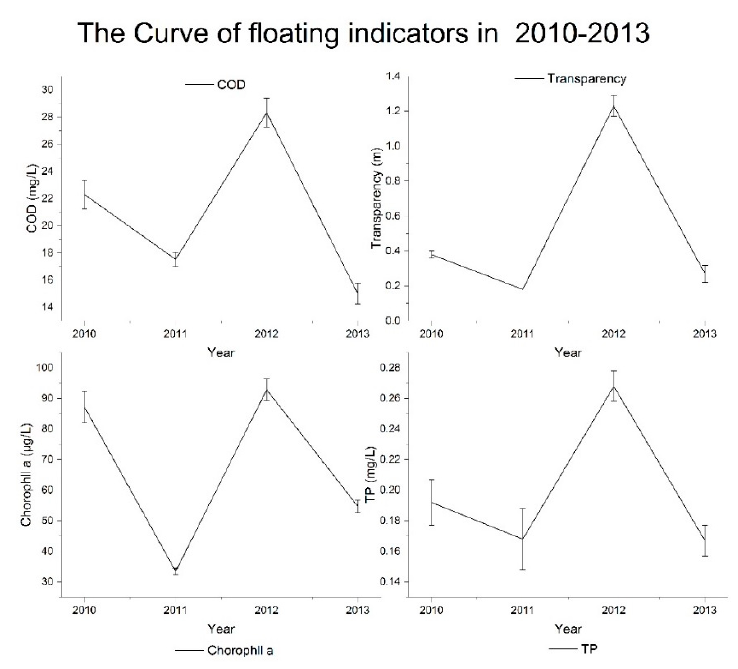
Figure 4. The average concentration curves of floating indicators from 2010 to 2013.